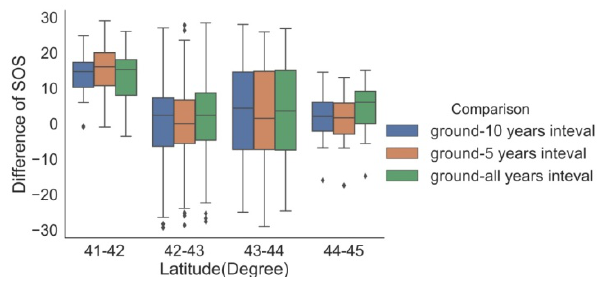
Figure 5. Difference between LSP SOS and ground SOS The LSP SOS in different time intervals was not significantly different comparing with the ground SOS. Difference between LSP SOS and ground SOS also existed among latitude. Difference of SOS during 41° and 42°, 44° and 45° was smaller than difference during 42° and 43 °, 43° and 44°. However, difference of SOS between 41° and 42° was larger than other latitude with the median value more than 10 days. SOS between 44° and 45° had the smallest different with the median value around 2 days (Figure 5).